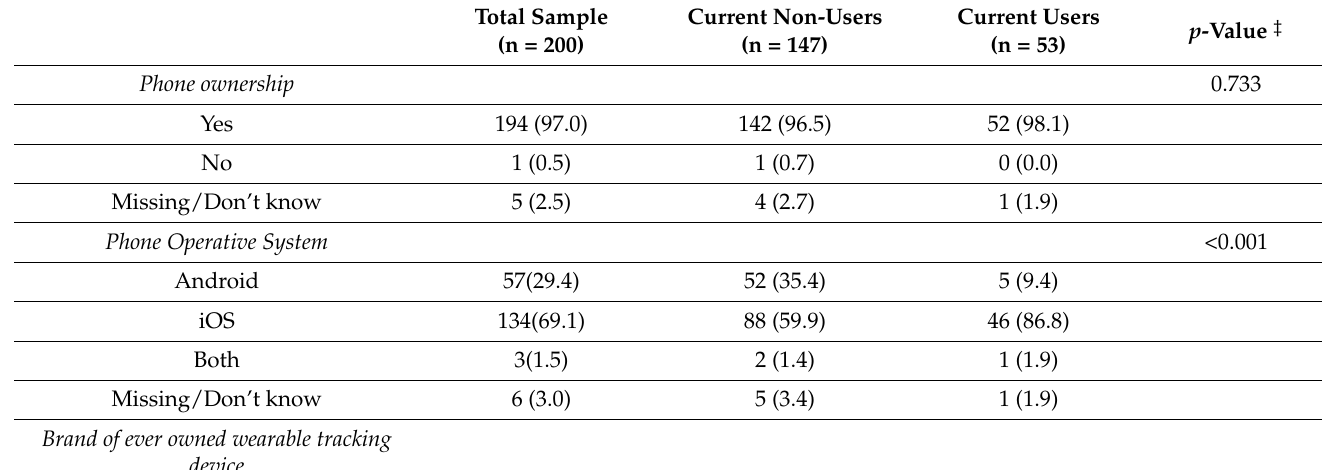
Table 2. Use of technology among the total sample, and among current users and non-users of health and fitness wear- able